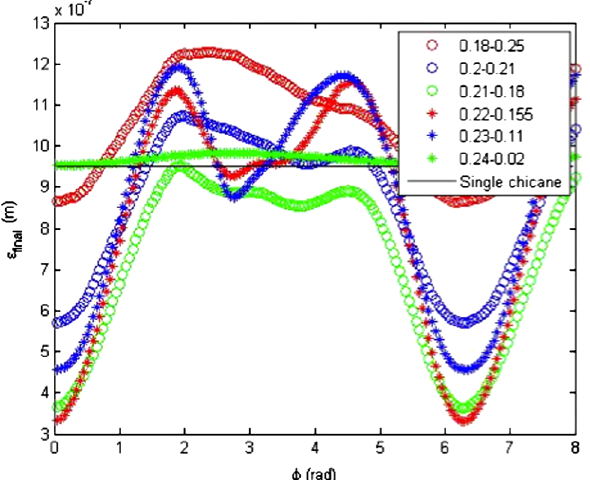
.FIG. 7. Horizontal projected normalized emittance as function of the bending angles of the chicanes (listed in the box in the right-upper corner of the graph) and the betatron phase advance between chicanes. The vertical axis is the resulting projected normalized emittance after the bunch compressor. The horizon- tal axis is the phase advance between two chicanes. The initial normalized emittance before compression is 0 : 2 (cid:1) m and the baseline single chicane scheme with a growth factor of 5 is also shown.